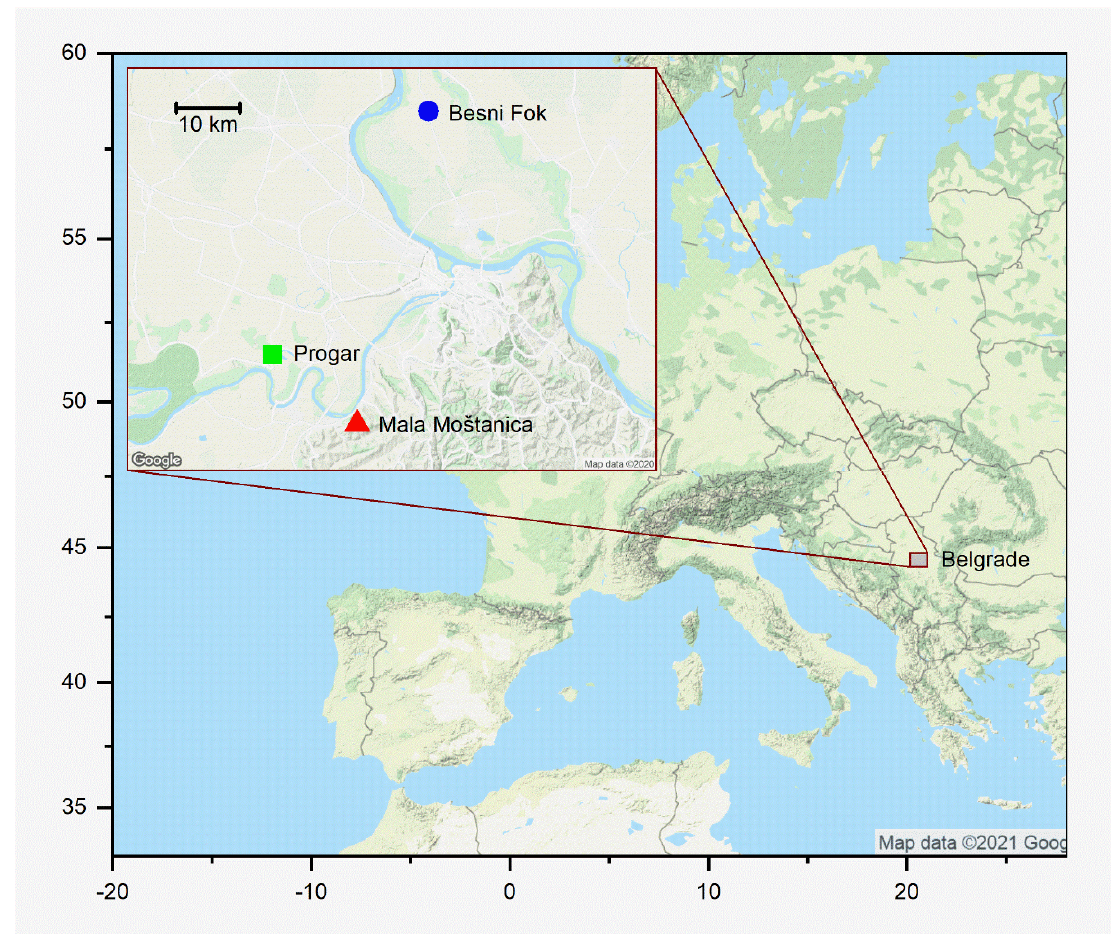
Figure 2. Location of the three Quercus robur forests studied, near Belgrade, Serbia. Ten of the 50 leaves sampled from each tree were placed separately into plastic Petri dishes. Leaf petioles were wrapped in cotton moistened with sterile distilled water. Pow- dery patches were observed under a binocular microscope (Olympus SZ-7, Tokyo, Japan) and fungal traits were observed in detail using a light Magnum T Trinocular microscope (CETI, Batley, UK). All traits were compared with those reported by Takamatsu et al. [61] and Braun et al. [62]. Based on the morphology of conidiophores and conidia, the number of asci in chasmothecia (i.e., sexual structures) and the shape of appendages, the powdery mildew observed was identified as E. alphitoides . In each tree, the percentage of leaf area affected by powdery mildew (infection severity) was estimated following Bert et al. [63]. Each of the 50 leaves sampled per tree was visually examined and assigned to one of the following damage groups: ‘0’ = no powdery mildew symptoms, ‘A’ = less than 50% of leaf surface with powdery mildew symptoms, ‘B’ = more than 50% of leaf surface with pow- dery mildew symptoms, and ‘C’ = whole leaf severely distorted and/or necrotic or dead. Whole tree infection severity was calculated using the equation of Bert et al. [63] as fol- lows: Severity = 0.25 × (percentage of leaves in group A) + 0.75 × (percentage of leaves in group B) + 1 × (per- centage of leaves in group C) Tree infection severity ranged from 0 to 100, corresponding to an infected leaf area percentage of 0 to 100%. We used this equation because the infection severity values fol- lowed a Gaussian distribution and to ensure our observations were comparable with those of previous studies [63].